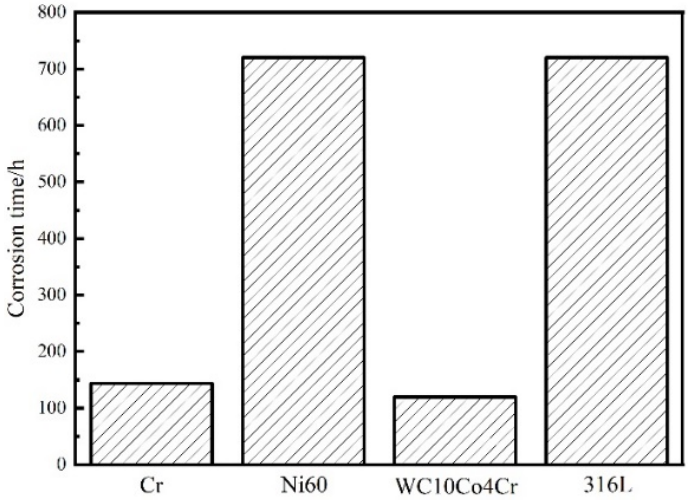
Figure 7. Neutral salt spray test of hard chrome plating and HVOF coatings.